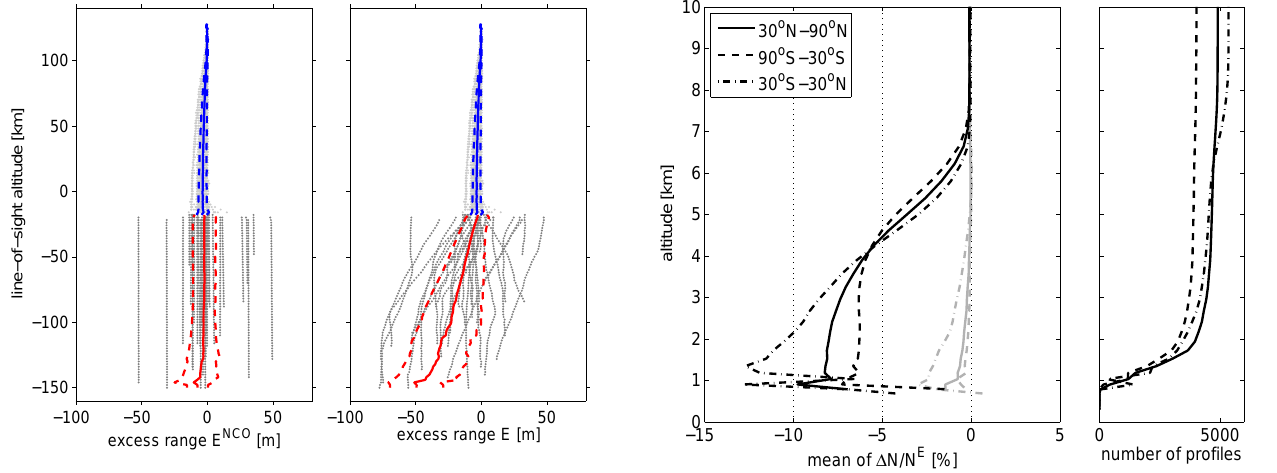
Fig. 8. Left: Fractional refractivity error derived solely from (single differencing) NCO phase data ignoring contributions from the residual phase samples (black lines). The results for the full measurement period (24 July and 17 November 2008) at three latitudinal bands are plotted as solid, dashed and dashed-dotted lines, respec- tively. For comparison the results obtained from the total (NCO plus residual) phase samples are shown as well (grey lines). Right: number of data points within the three latitudinal regions.